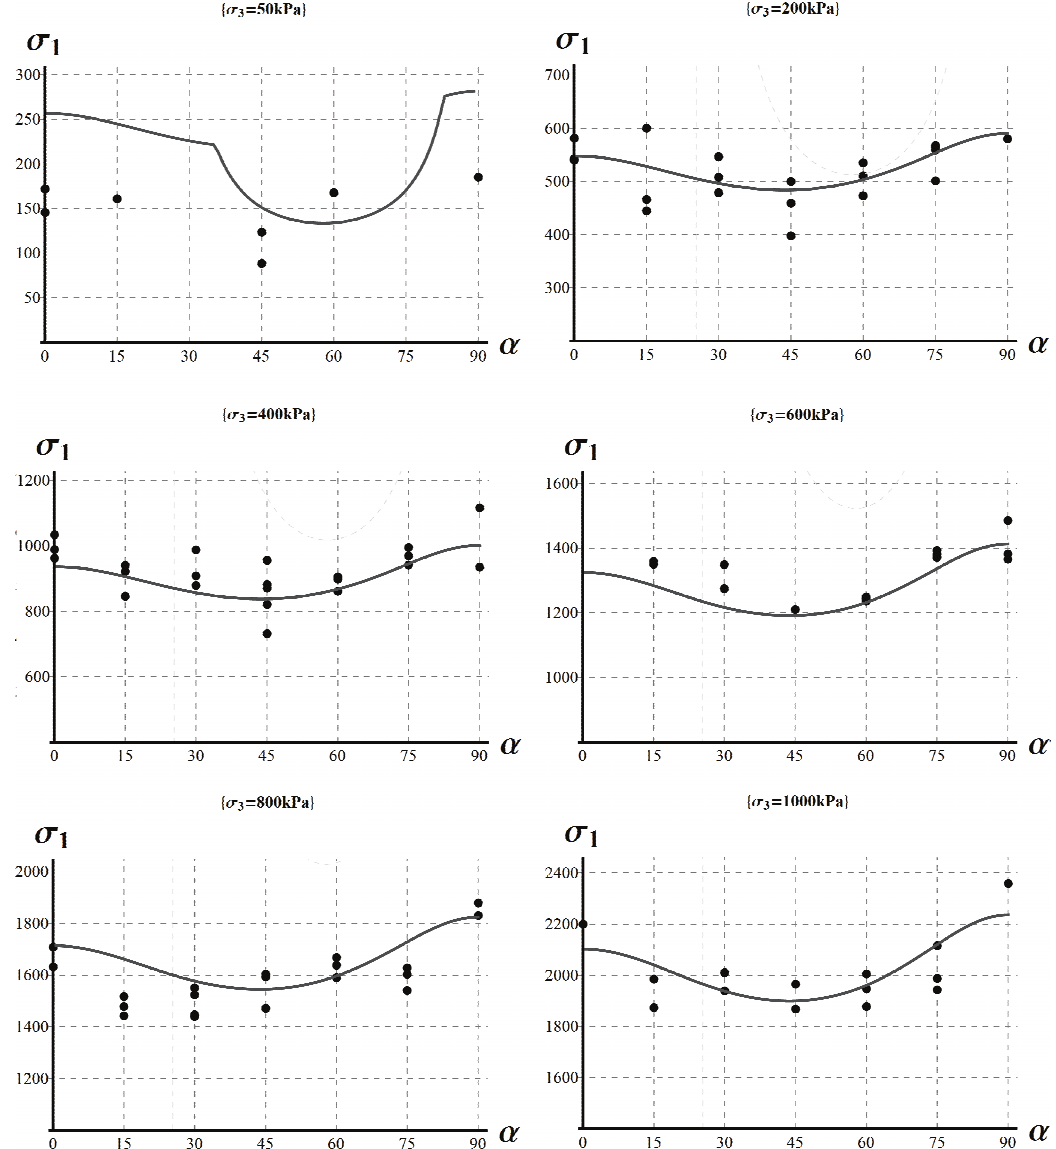
Fig. 4. Comparison of the Pariseau criterion with a single weakness plane (continuous line) with the experimental data